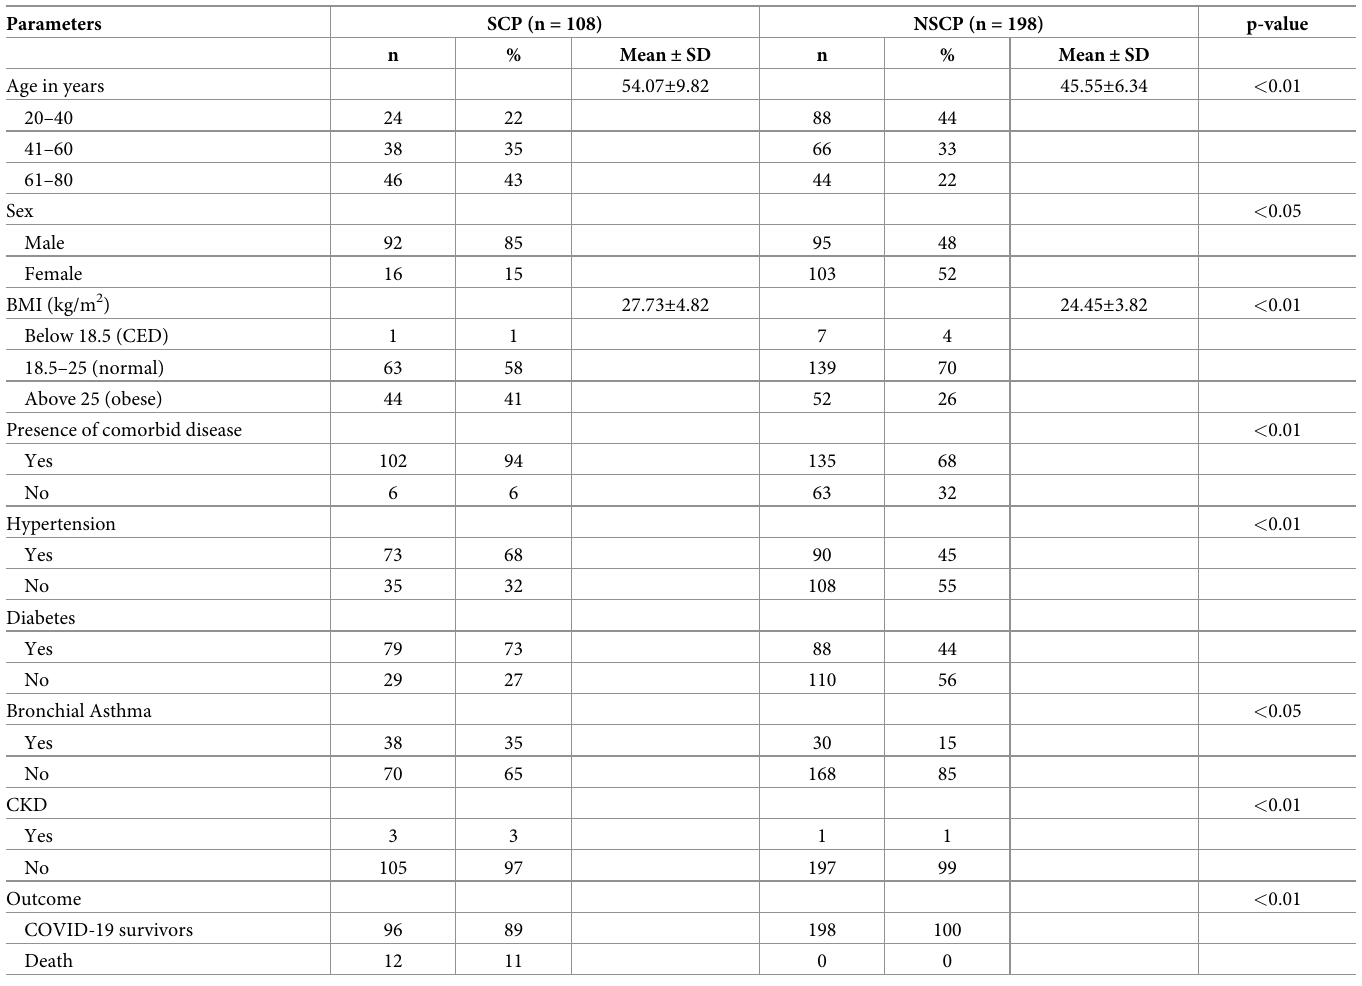
Table 1. Characteristics and comorbid diseases of COVID-19